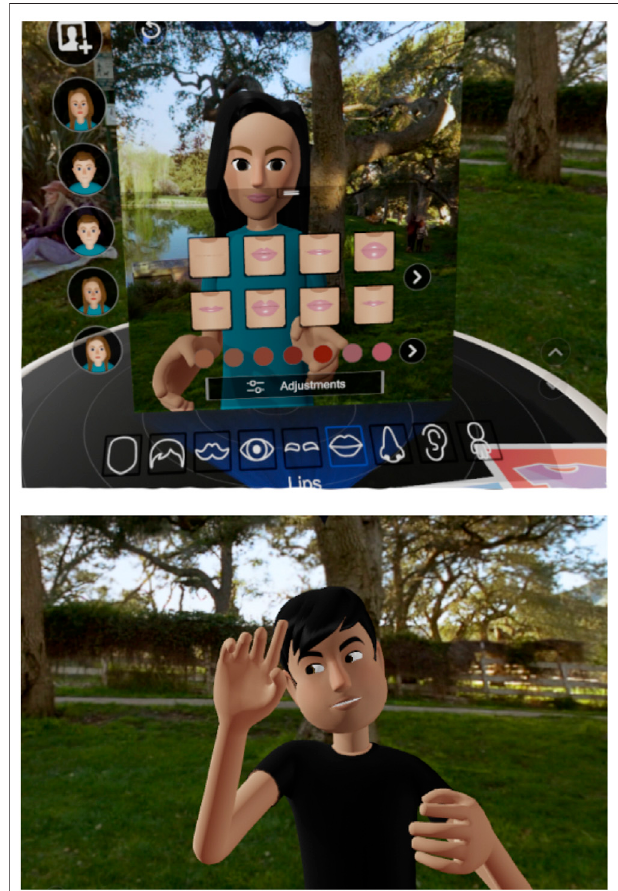
FIGURE1| Top:ParticipantscreatedtheiravatarinFacebookSpacesin the beginning of every session before starting the conversation with the other participant. Bottom: Participants saw a table, their partner ’ s avatar and a 360-degree panoramic photograph of a park.